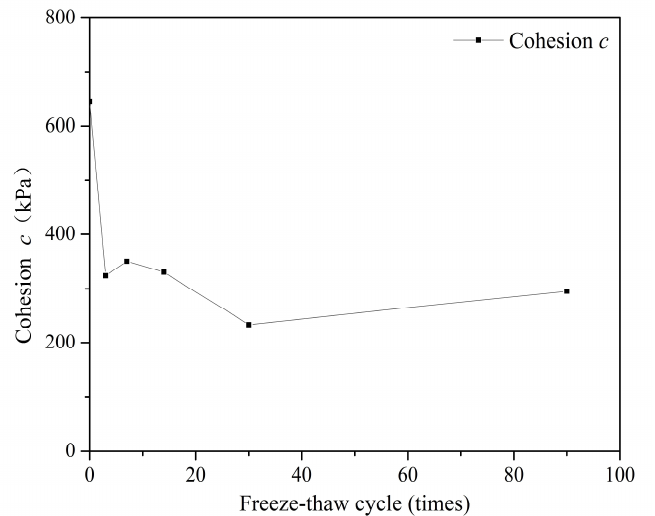
Figure 8. Variation of cohesion, C , of S/S lead-zinc-cadmium composite HM-contaminated soil with F-T cycles.